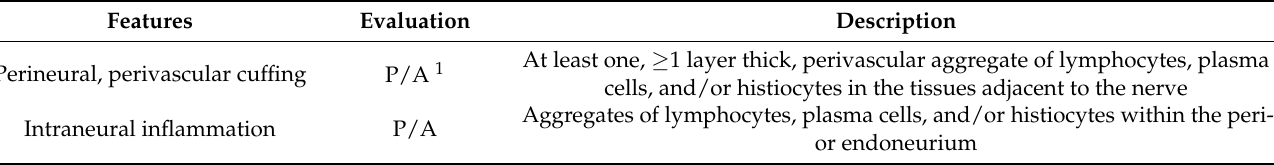
Table A4. Histopathological features evaluated in the peripheral nervous system (subcutaneous-thoracic, sciatic, tibial, and radial nerves).